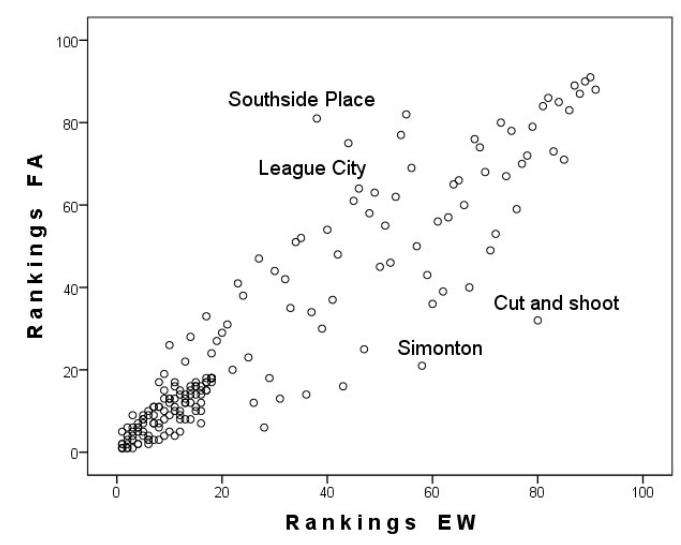
Figure 2: Correlations between the LURE Index and Alternative Scenario Using EW